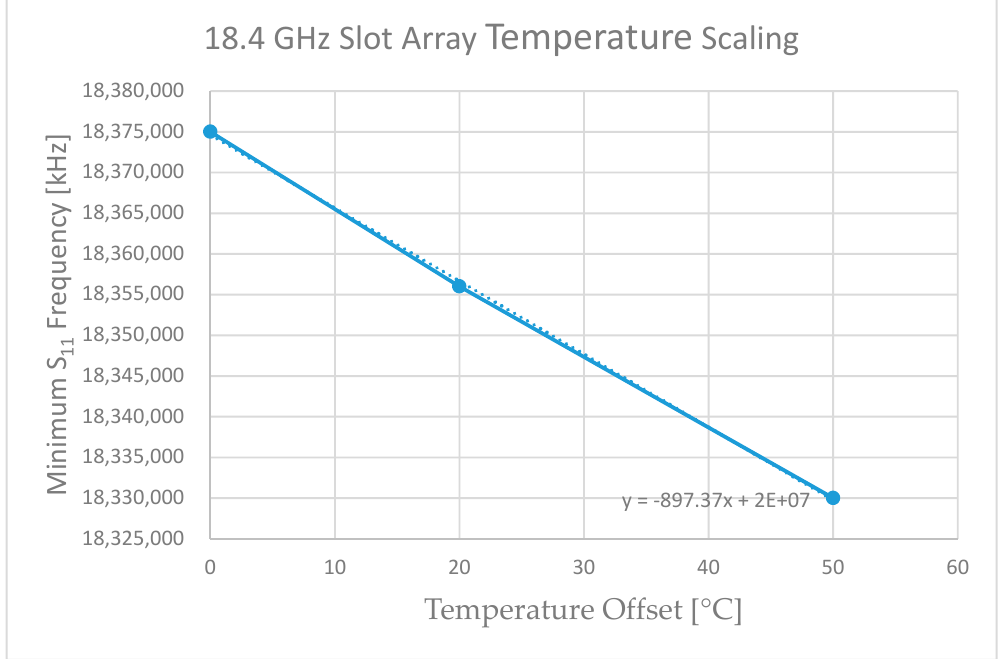
Figure 2. 18.4 GHz slot array temperature scaling.